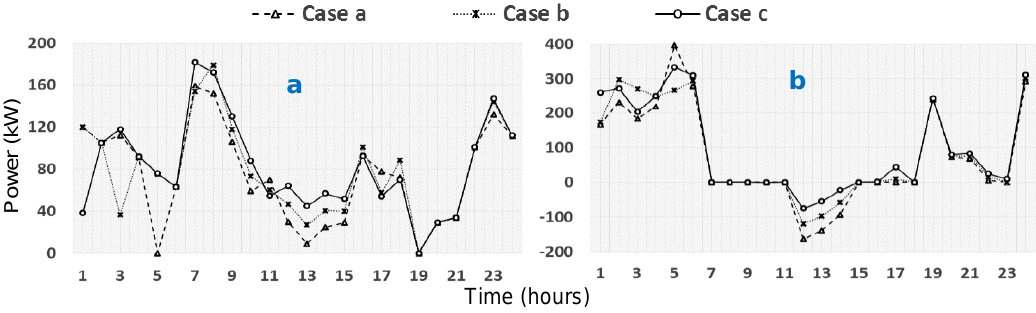
Figure 7. Collective power trading: ( a ) Internal trading; and ( b ) External trading.